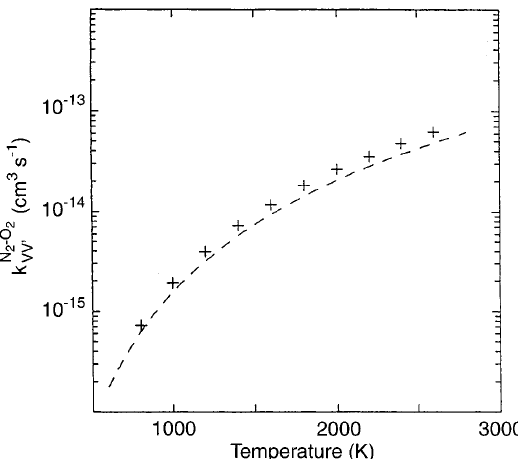
Fig. 5. The temperature dependence of the rate coe(cid:129)cient for the VV 0 - process N 2 (cid:133) 1 (cid:134) (cid:135) O 2 (cid:133) 0 (cid:134) ! N 2 (cid:133) 0 (cid:134) (cid:135) O 2 (cid:133) 1 (cid:134) : dashed line , our calcula- tion; crosses , experimental data of Gilmore et al .